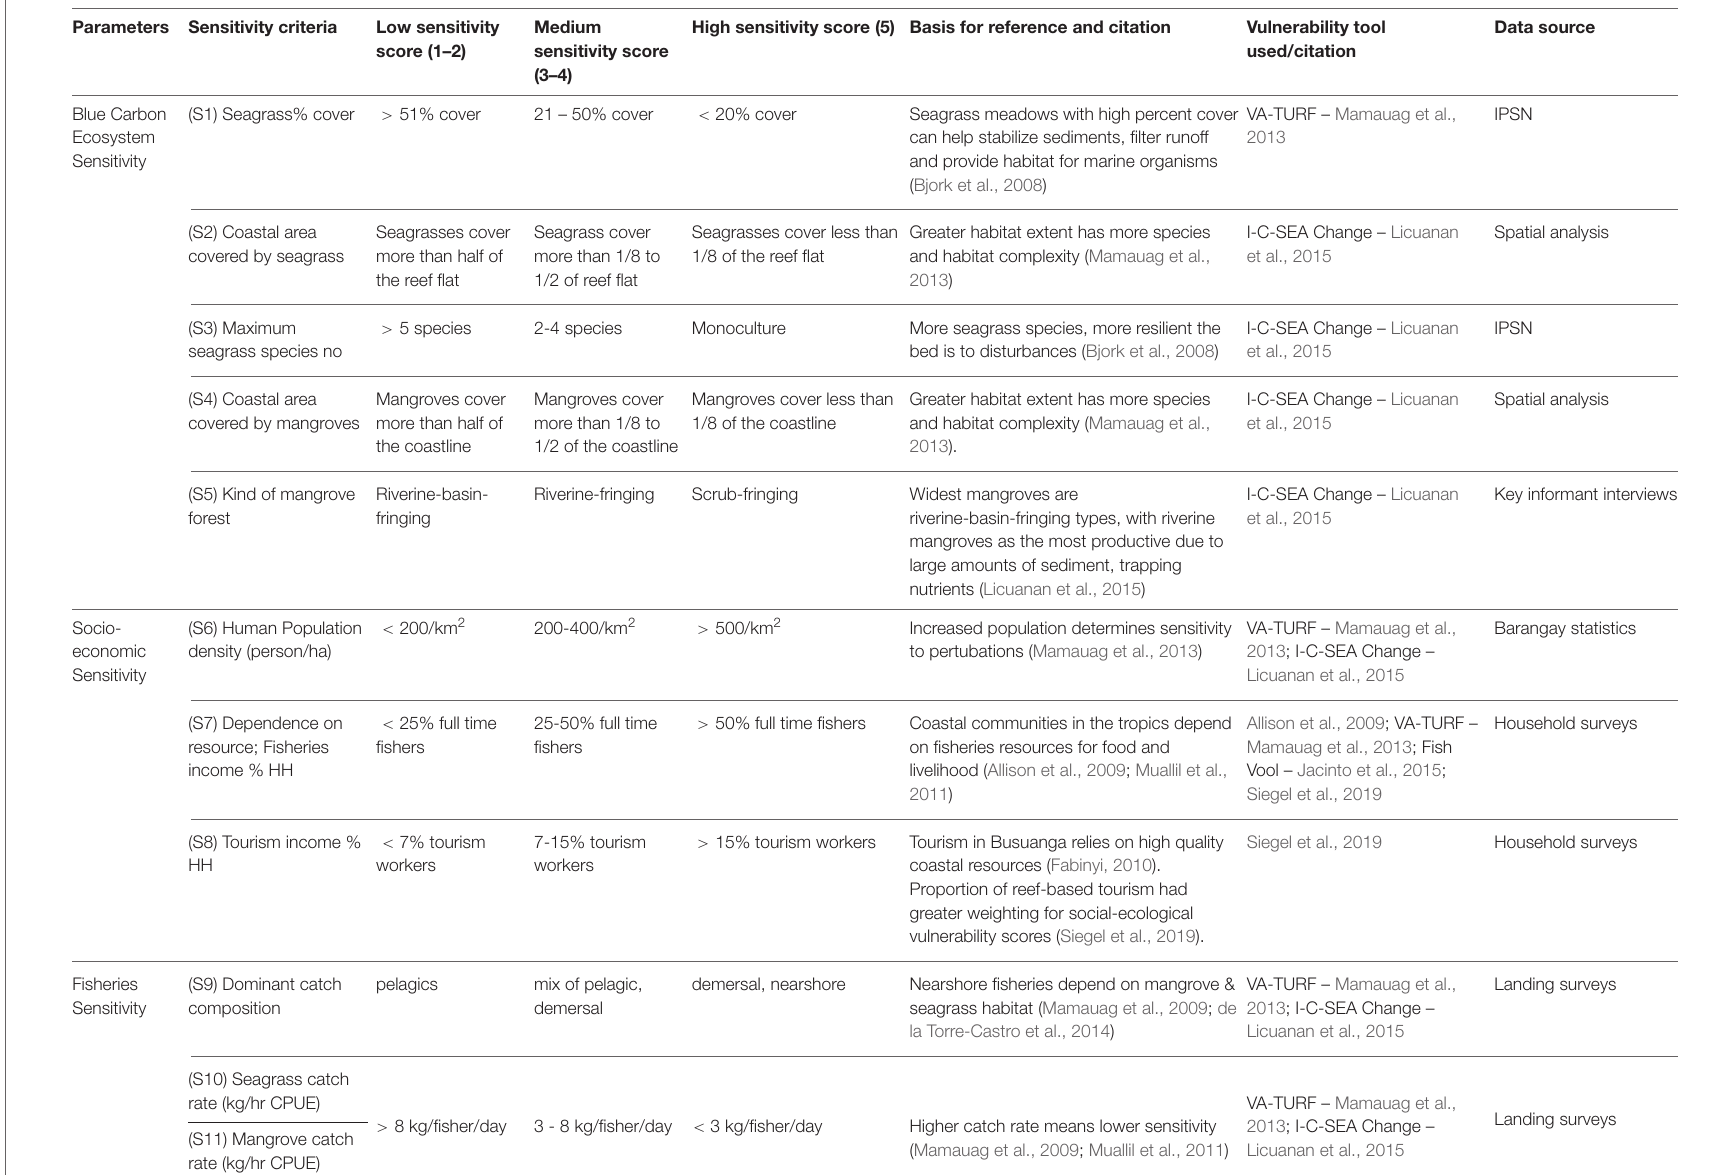
TABLE 2 | Sensitivity criteria. Parameters Sensitivity